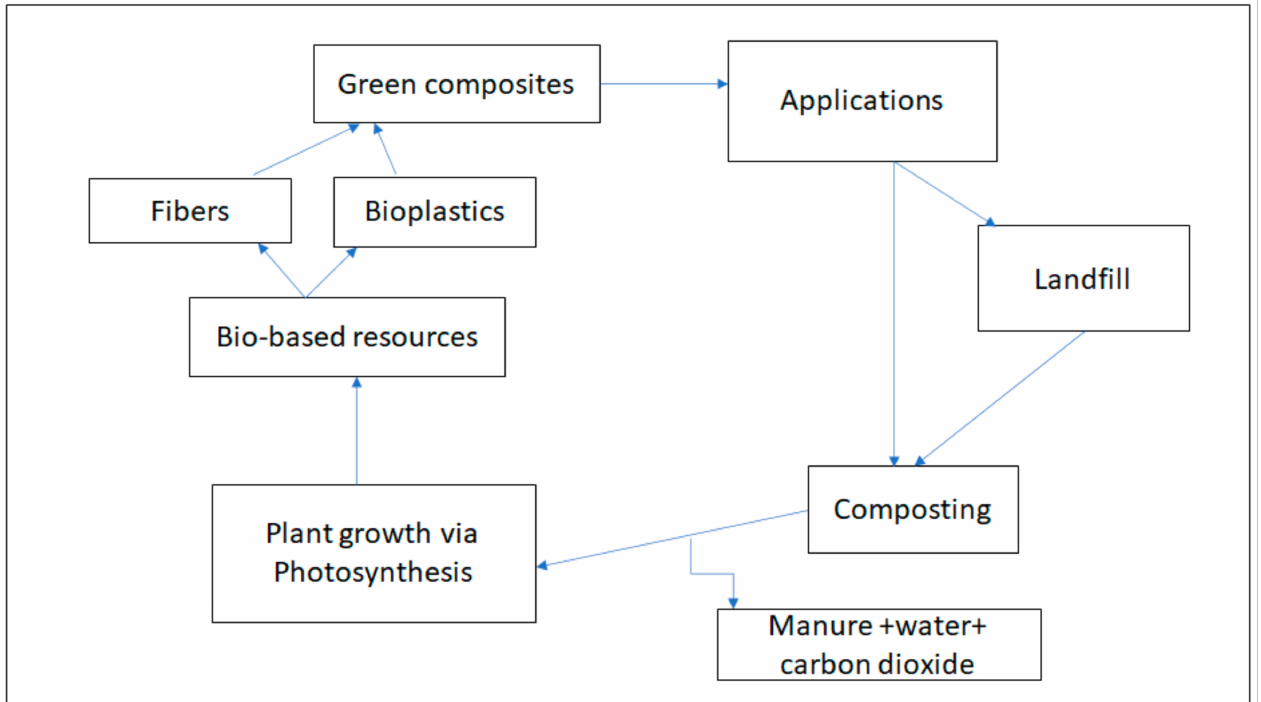
Figure 9. Typical example of the expected life cycle of a green